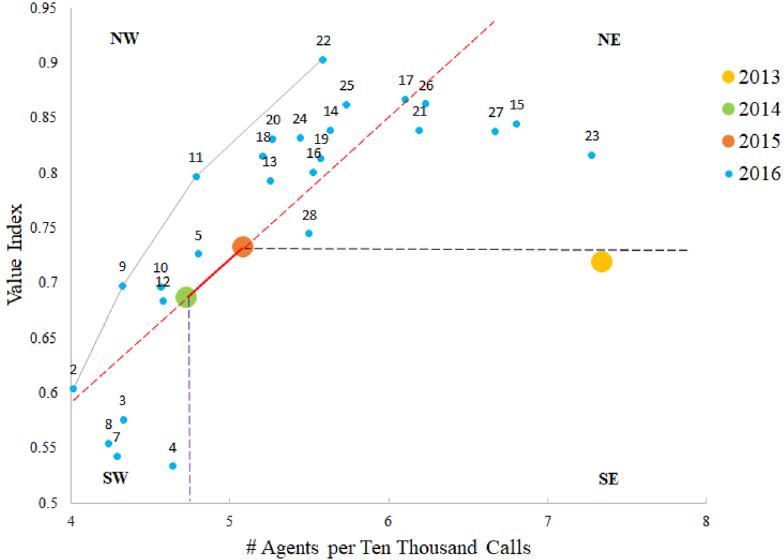
Fig. 2 Using Efficiency Frontier to evaluate 2016